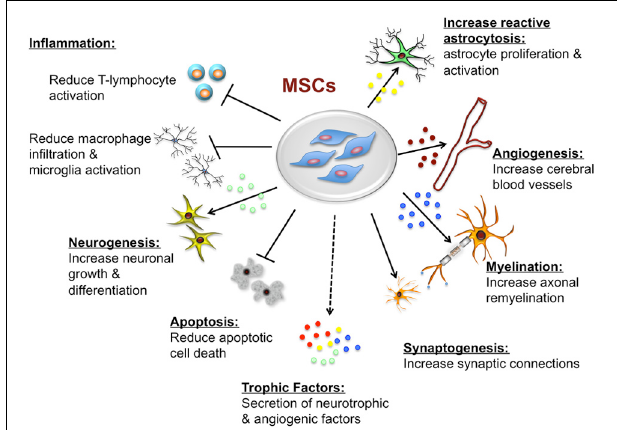
FIGURE 3 | Potential neuroprotective and neurorestorative effects of mesenchymal stem cells (MSCs). The beneficial actions of MSCs are mediated primarily by paracrine actions. MSCs secrete a number of neurotrophic and angiogenic factors that promote neuronal growth and differentiation, induce angiogenesis, neurogenesis and astroglial growth and activation, they promote synaptogenesis thus enhancing synaptic connections and axonal remyelination, decrease apoptosis, and decrease macrophage infiltration, and microglia and T-lymphocyte